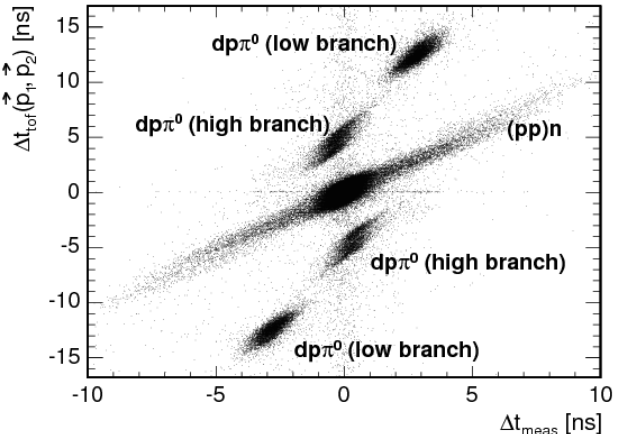
and meas FIG. 7. Missing mass squared for the dp ! 3 He X reaction showing a Gaussian fit to a clearly identified (cid:1) 0